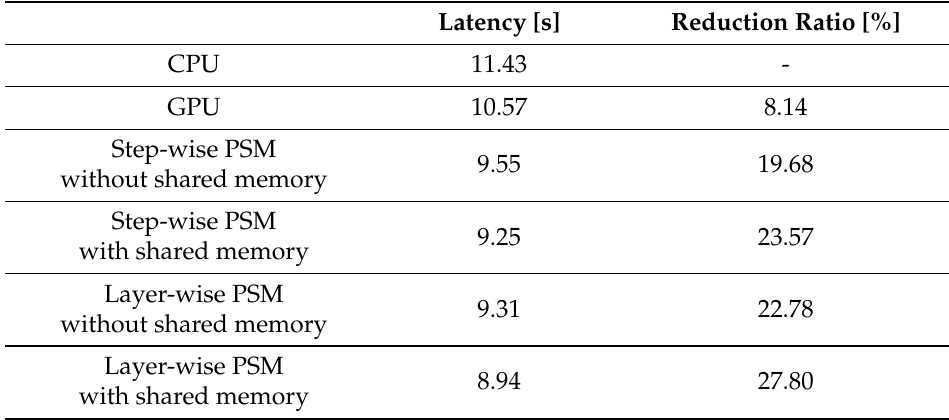
Table 1. The experiments of training the neural network model with a batch of 32 including latency executed by step-wise PSM and layer-wise PSM and latency reduction rate compared to